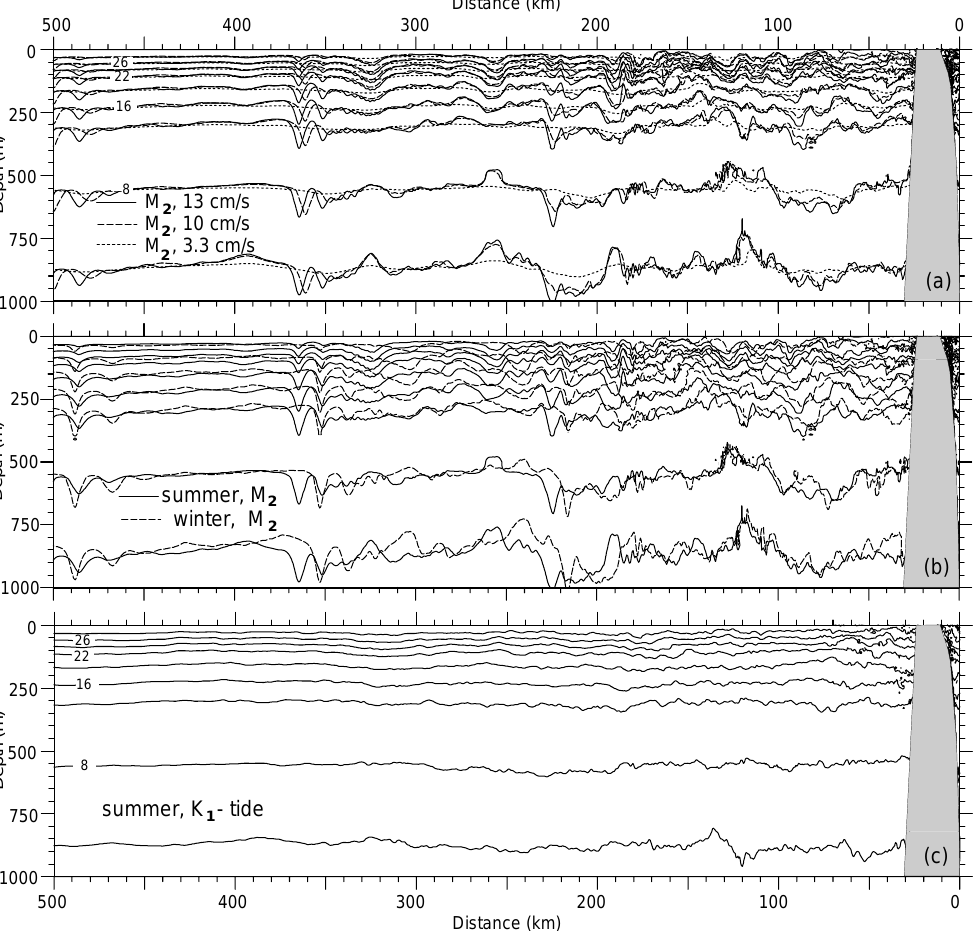
Fig. 15. Model-predicted temperature fields in the cross-section (b) shown in Fig. 3 after five tidal cycles calculated for (a) three tidal currents of different amplitude, (b) summer and winter stratification, and (c) K 1 tidal